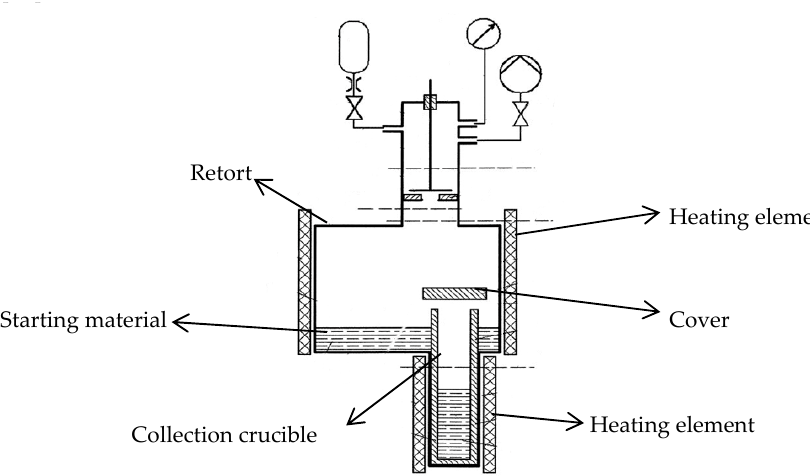
Figure 7. Vacuum distillation retort as devised by Uggowitzer et al .